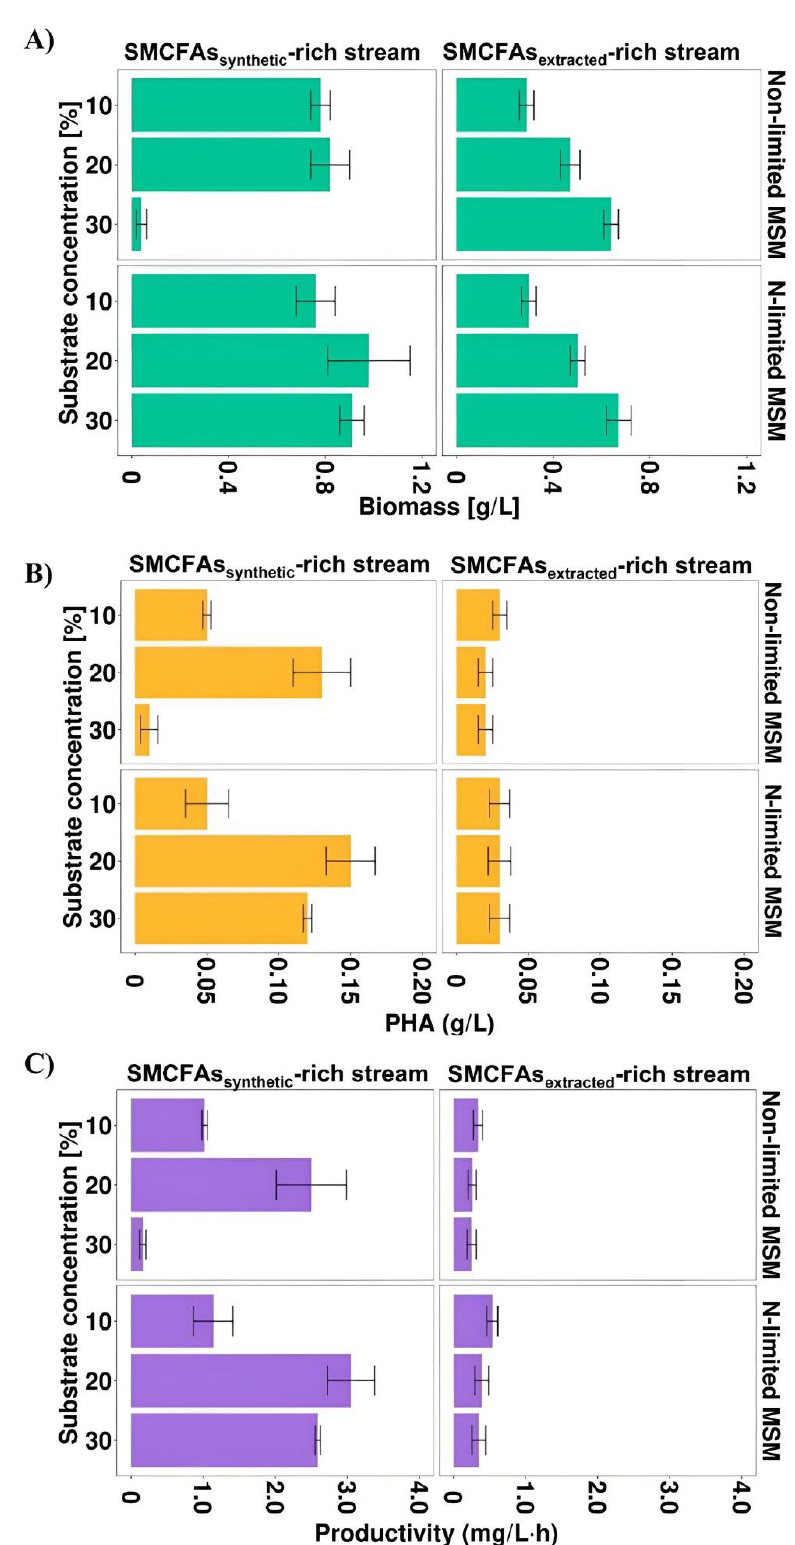
Figure 3. ( A ) Biomass concentration, ( B ) PHA concentration and ( C ) PHA productivity profiles of Aeromonas sp. AC_01 at 48 h of the cultivations supplemented with SMCFAs synthetic -rich stream and